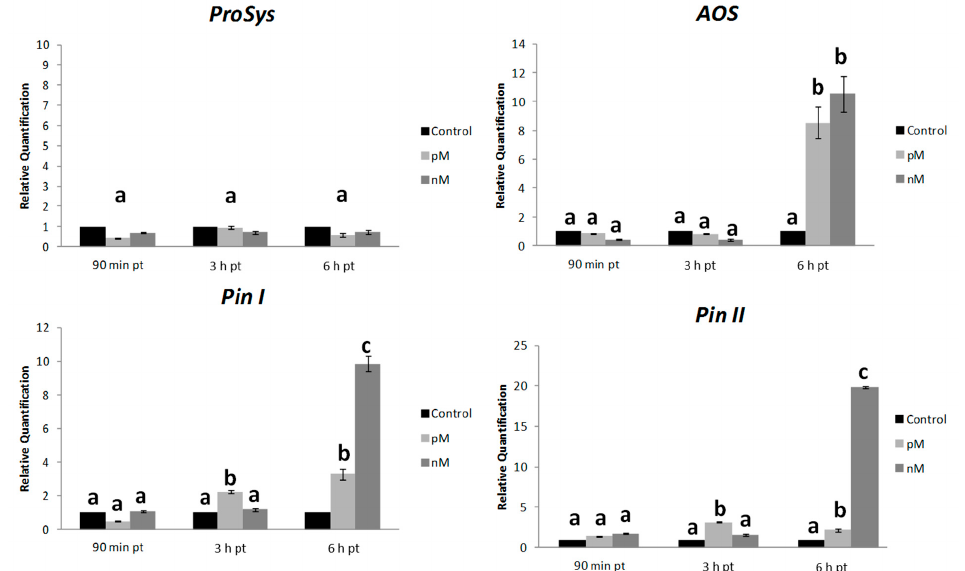
Figure 8. Systemic gene expression analysis in leaves upon Sys foliar treatment. Quantification of transcripts of early ( ProSys, AOS ) and late genes ( Pin I, Pin II ) in leaves distal from the treated ones by real time RT-PCR after 90 min, 3 h and 6 h following 100 pM and 100 nM systemin peptide treatment. Relative quantities are calibrated on samples obtained from tomato leaves spotted with PBS1X (Control). For each gene, RQ variations have been analysed by two-way ANOVA. Different letters denote significantly different values ( ProSys : p > 0.05; AOS : p < 0.01 6 h pt; Pin I and Pin II : p < 0.05 3 h pt, p < 0.01 6 h pt). Error bars indicate standard error.